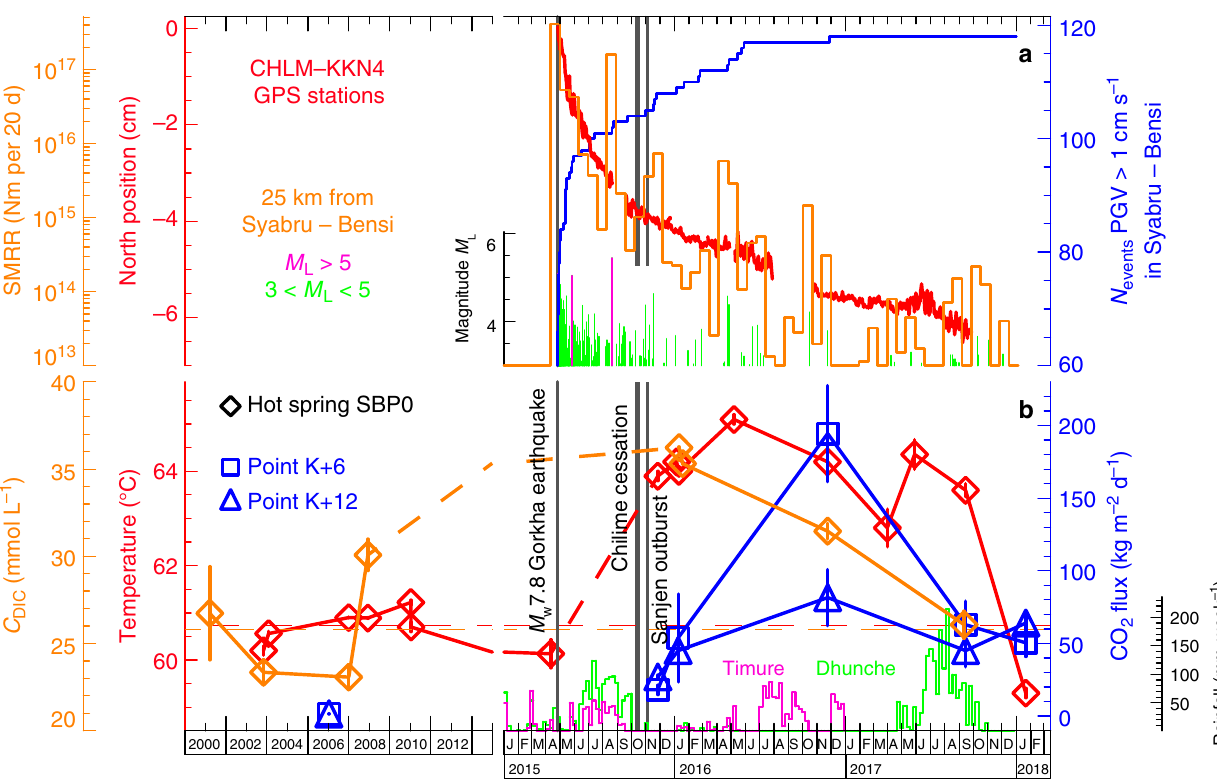
Fig. 3 Temporal changes in selected parameters in Syabru-Bensi, Upper Trisuli valley. a Corrected northward position difference of GPS stations CHLM minus KKN4 (red), cumulated number of aftershocks with vertical Peak Ground Velocity (PGV) higher than 1 cm s − 1 in Syabru-Bensi (blue) (Supplementary Fig. 12), Seismic Moment Release Rate (SMRR) (orange) and local magnitude (green and purple) of earthquakes ≤ 25 kilometres from Syabru-Bensi. The CHLM minus KKN4 difference of the vertical position helps cancelling most of the seasonal variations. Aftershock epicentres from 25 April 2015 to 31 December 2017 (NSC) are taken into account. b Water temperature (red) and dissolved inorganic carbon (DIC) concentration (orange) of the main hot spring of Syabru-Bensi (SBP0) from 2001 to 2018, surface CO 2 fl uxes (blue) at two locations on the alluvial terrace above the hot spring, K + 6 and K + 12 (Fig. 2 and Supplementary Fig. 2), and the 2015 – 2017 rainfall data in Dhunche, seven kilometres southwest to Syabru-Bensi (green), and Timure, nine kilometres to the north (purple) (courtesy of Nepal Department of Meteorology, Kathmandu). Pre-earthquake water temperature and DIC concentration of SBP0 are compiled from our database and the literature 30 . Timing of the Gorkha earthquake, the Chilime hot spring cessation and the Sanjen CO 2 outburst are displayed as vertical grey lines. Possible pre-seismic water-cooling of 0.6 ± 0.2 °C is observed 2 weeks before the earthquake, followed by a progressive warming reaching 4.4 ± 0.2 °C about 1 year after the earthquake, which persisted >2 years after the mainshock. Water temperature returned to pre-earthquake values in January 2018, more than 2.7 years after. Water-cooling was observed a few weeks before the earthquake at three other hot springs of the Upper Trisuli valley (Supplementary Fig. 9). The DIC concentration increased by 29 ± 2% after the mainshock and returned to pre-earthquake values in September 2017. Compared with CO 2 fl ux values obtained in 2006 (ref. 33 ), close to local background level, the post-seismic values were signi fi cantly larger in November 2015 and January 2016 (increase factors of 150 ± 30 and 160 ± 20 for K + 6 and K + 12, respectively). The CO 2 fl uxes peaked in November 2016 and continued to show higher values in January 2018 compared with